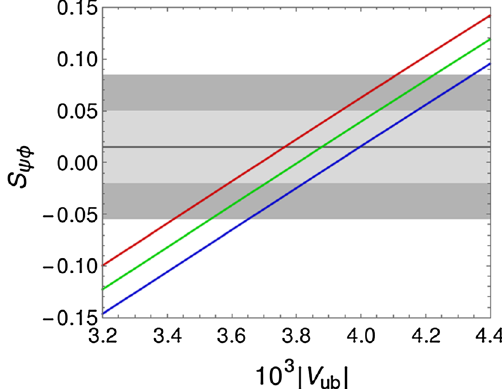
Fig. 6 Correlation between | V ub | and S ψφ in U ( 2 ) 3 models, for three different values of S ψ K : 0.674 (red), 0.691 (green), 0.708 (blue). The S experimental 1 σ and 2 σ regions for S ψφ are shown by the grey